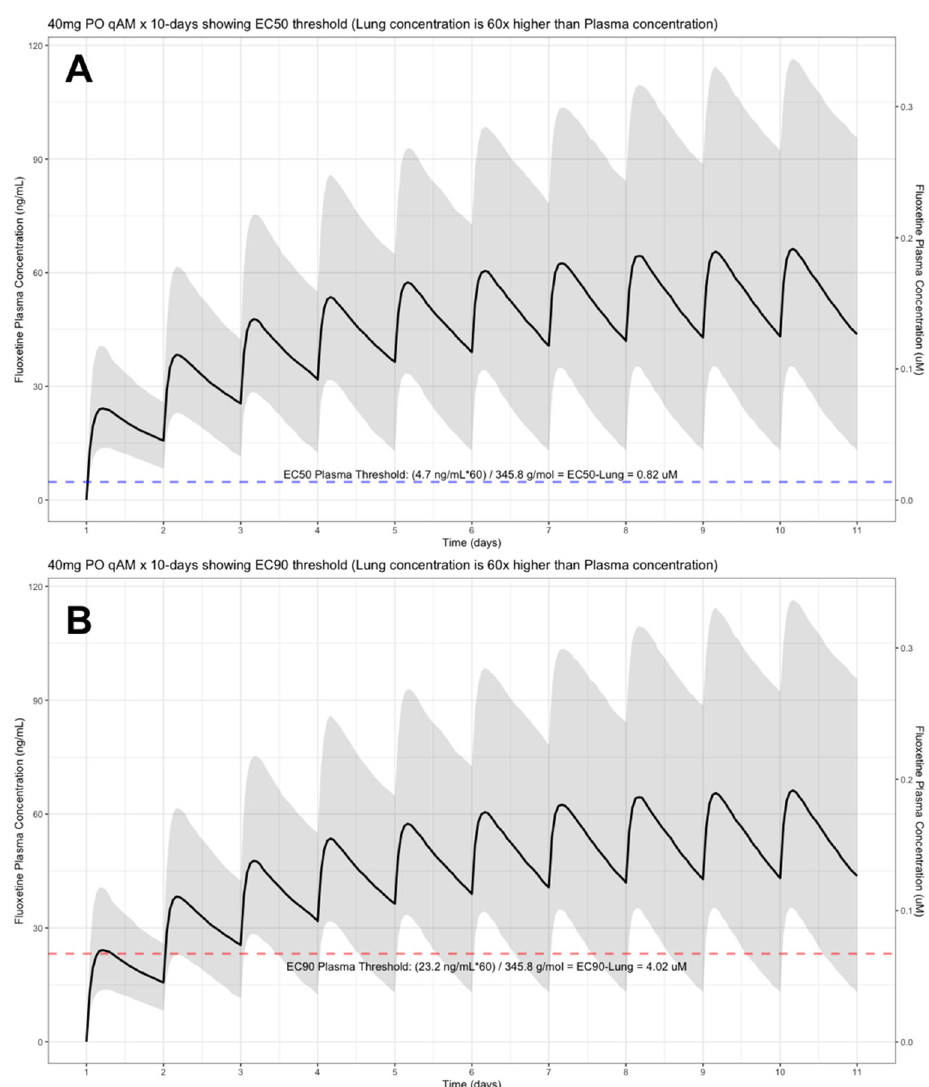
Figure 3. Fluoxetine population (n=1,000) dosing simulation results for an oral dose of 40 mg/day for 10 days. The shaded regions illustrate the 10th (lower) and 90th (upper) percentiles with the solid line within the shaded region representing the median fluoxetine concentration. The dashed horizontal line depicts the effective concen- tration resulting (A) 50% and (B) 90% inhibition (EC90) of SARS-CoV-2 that will result in 60-times higher level in the